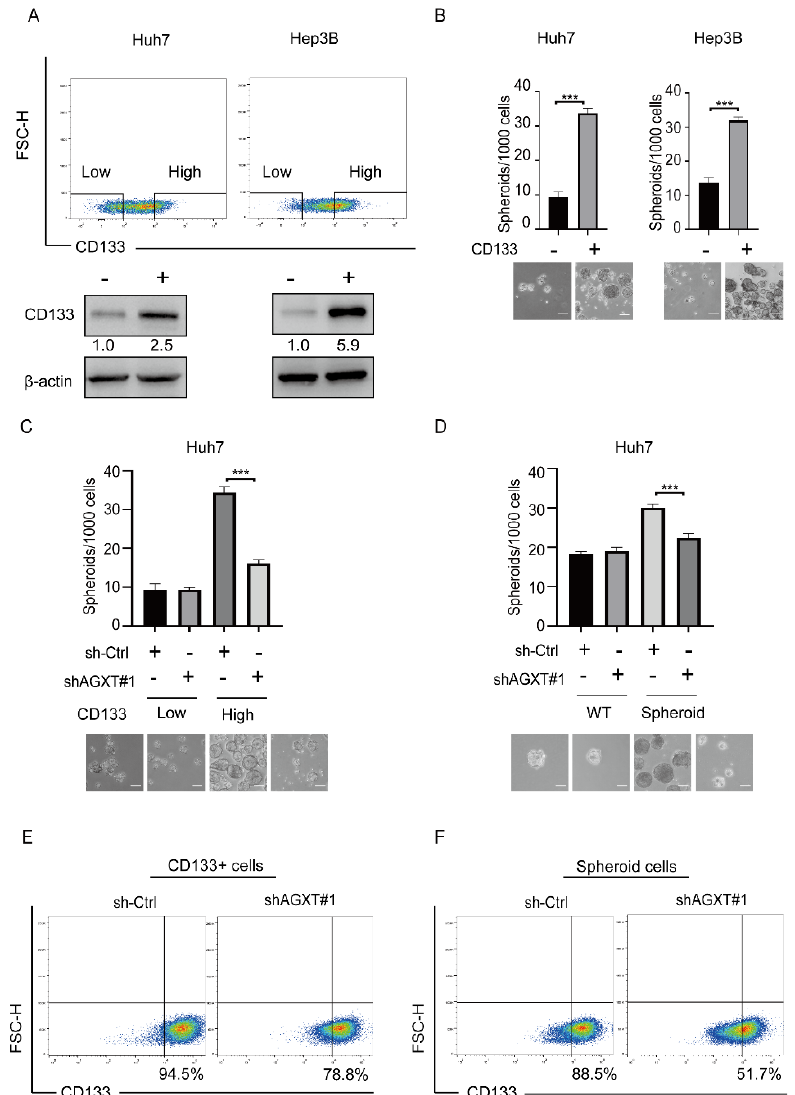
Figure 3. Alanine − glyoxylate aminotransferase (AGXT) expression is essential for the stemness properties of cancer stem cells: ( A ) Differentiation of CD133 + cells and CD133 − cells through flow cytometry in the Huh7 cells and Hep3B cells. The protein level of CD133 was detected through Western blot after the culture; ( B ) sphere formation assay of CD133 + and CD133 − Huh7 and Hep3B cells and the quantification of spheroid numbers. Scale bar, 100 µ m; ( C ) sphere formation assay of AGXT knockdown and knockdown control in CD133 + and CD133 − Huh7 cells and the quantification of spheroid numbers. Scale bar, 100 µ m; ( D ) sphere formation assay of AGXT knockdown in wild − type and spheroid Huh7 cells, and the quantification of spheroid numbers. Scale bar, 100 µ m; ( E ) flow cytometry analysis of the CD133 + population decreased from 94.5% to 78.8% after AGXT knockdown; ( F ) flow cytometry analysis of spheroid cells decreased from 86.5% to 51.7% after AGXT knockdown. *** p < 0.001.